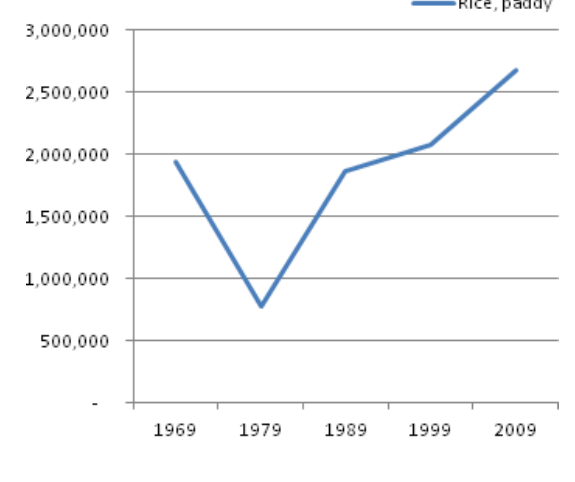
Fig. 1 . Harvest area for paddy rice in Cambodia (ha). Data